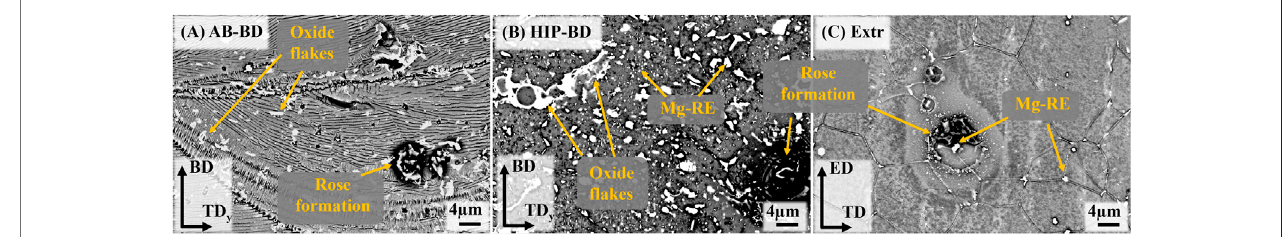
FIGURE 10 | BSE-SEM mages of the surfaces of (A) AB, (B) HIP and (C) Extr samples after 30 min immersion in DPBS.